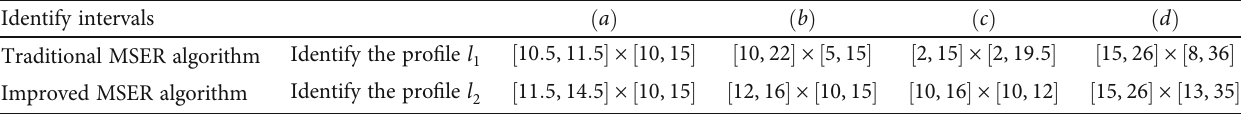
Table 2: Improved recognition of contour curves in front and rear areas.